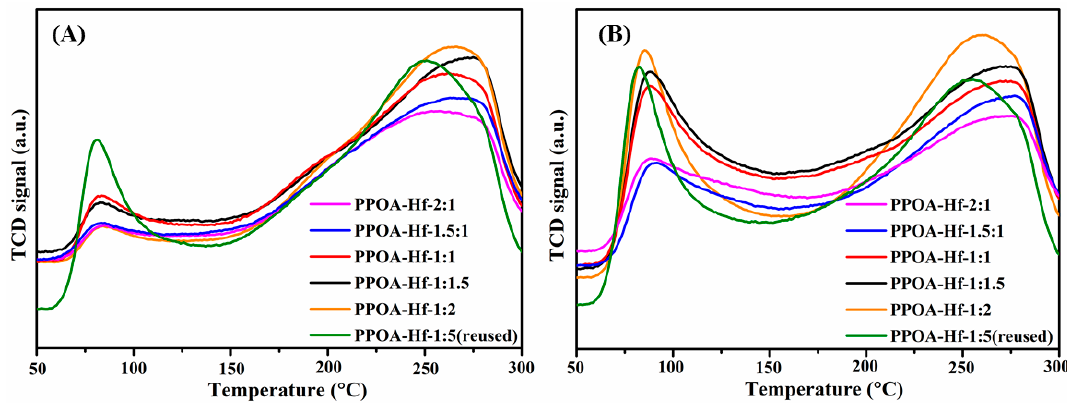
Figure 3. CO 2 - temperature programmed desorption (TPD) ( A ), and NH 3 -TPD ( B ) patterns of PPOA–Hf- x with various PPOA/Hf molar ratios.